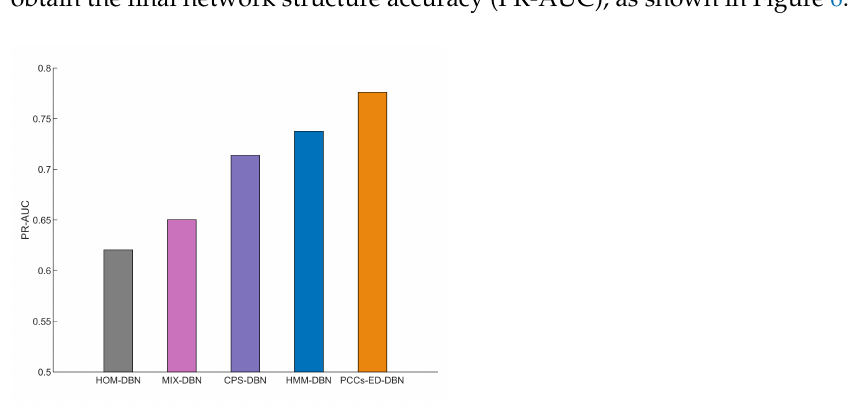
Figure 6. Accuracy comparison among different models on Saccharomyces cerevisiae